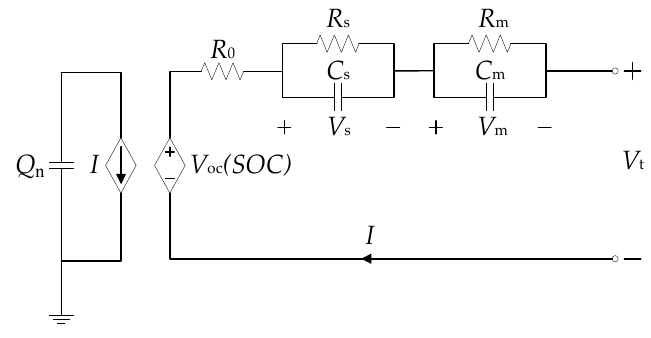
Figure 1. Second-order RC equivalent circuit model.